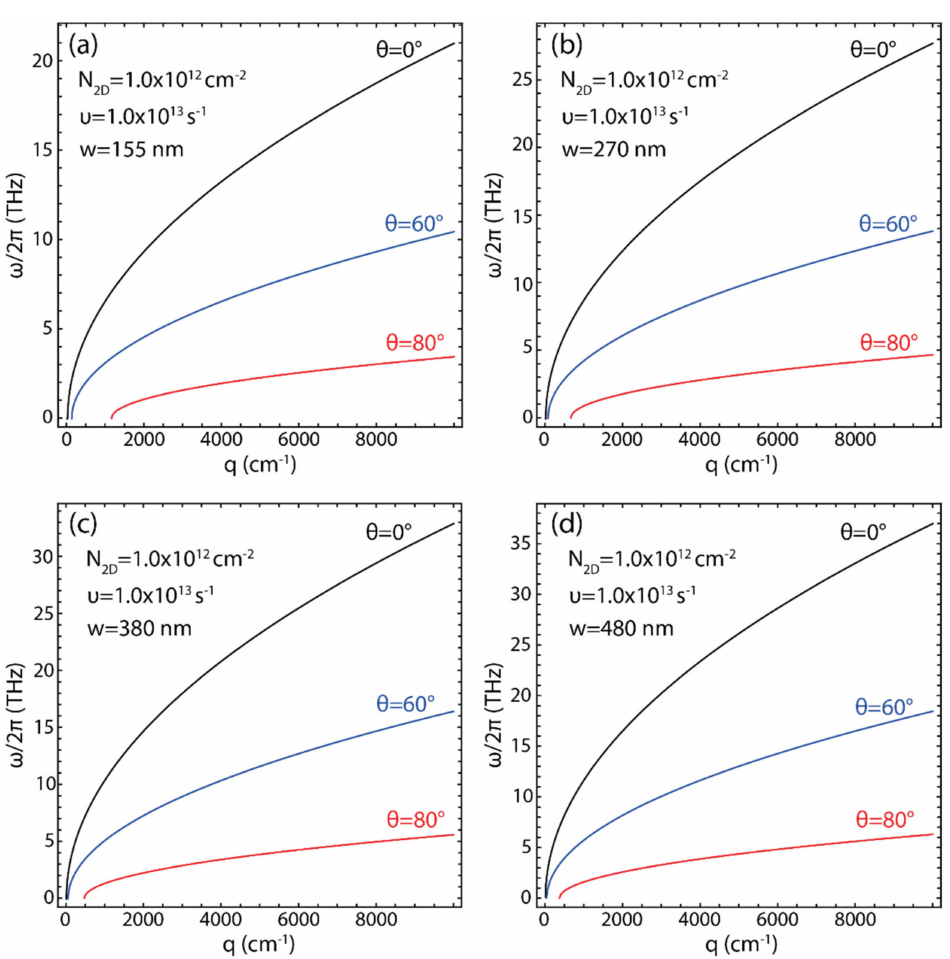
Figure 5. Plasmon frequency–momentum dispersion of 2D GNR arrays of interest, considering different orientations of plasmon excitation angle ( θ = 0, 60, 80): ( a ) w = 155 nm, ( b ) w = 270 nm, ( c ) w = 380 nm, and ( d ) w = 480